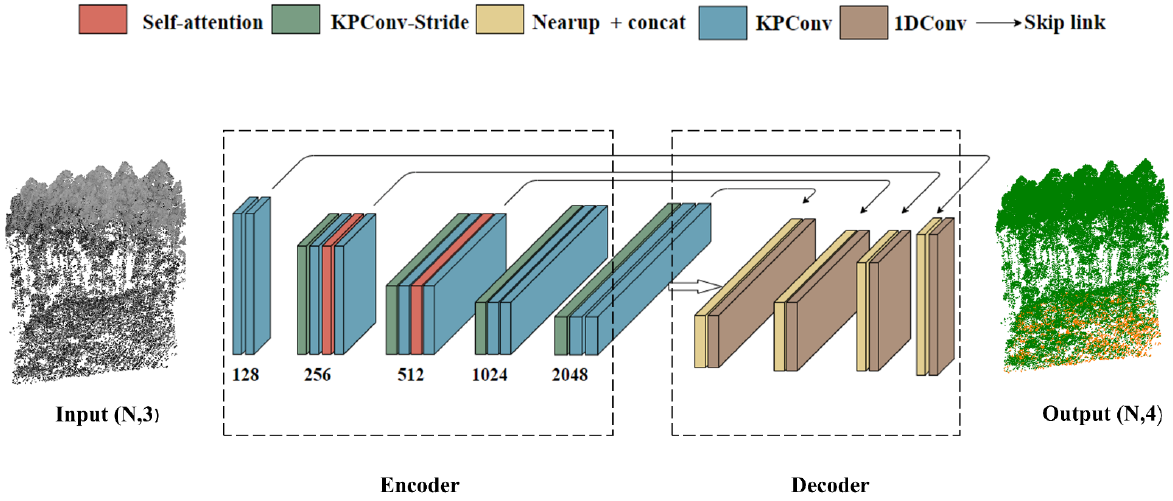
Figure 2. The structure of Terrain-net. The encoder part and decoder part were marked by dashed boxes.